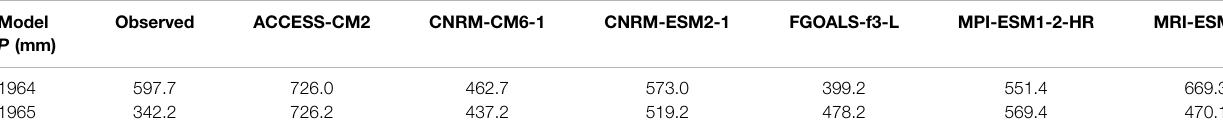
TABLE 4 | Annual precipitation of six higher-scoring GCMs and observed precipitation from 1964 to 1965.